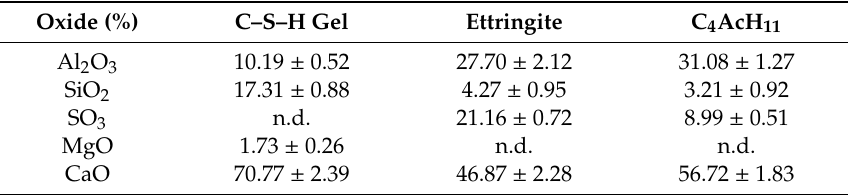
Figure 15. 29 Si NMR spectrum for 0 day and 90 days HcG waste. The 27 Al NMR spectra for 1 day and 90 days calcareous waste HcG are depicted in Figure 16. The two new Al (VI) signals were also identified by SEM. The one at 13.4 ppm denoted ettringite formation, while the other, at 9.6 ppm, was generated by a calcium aluminate hydrate, very likely C 4 AH 13 . From Antoni et al. [60] should be considered also the possibility to carboaluminate hydrated phases formation with very close resonances, 10.30 ppm for hemicarboaluminate and 8.7